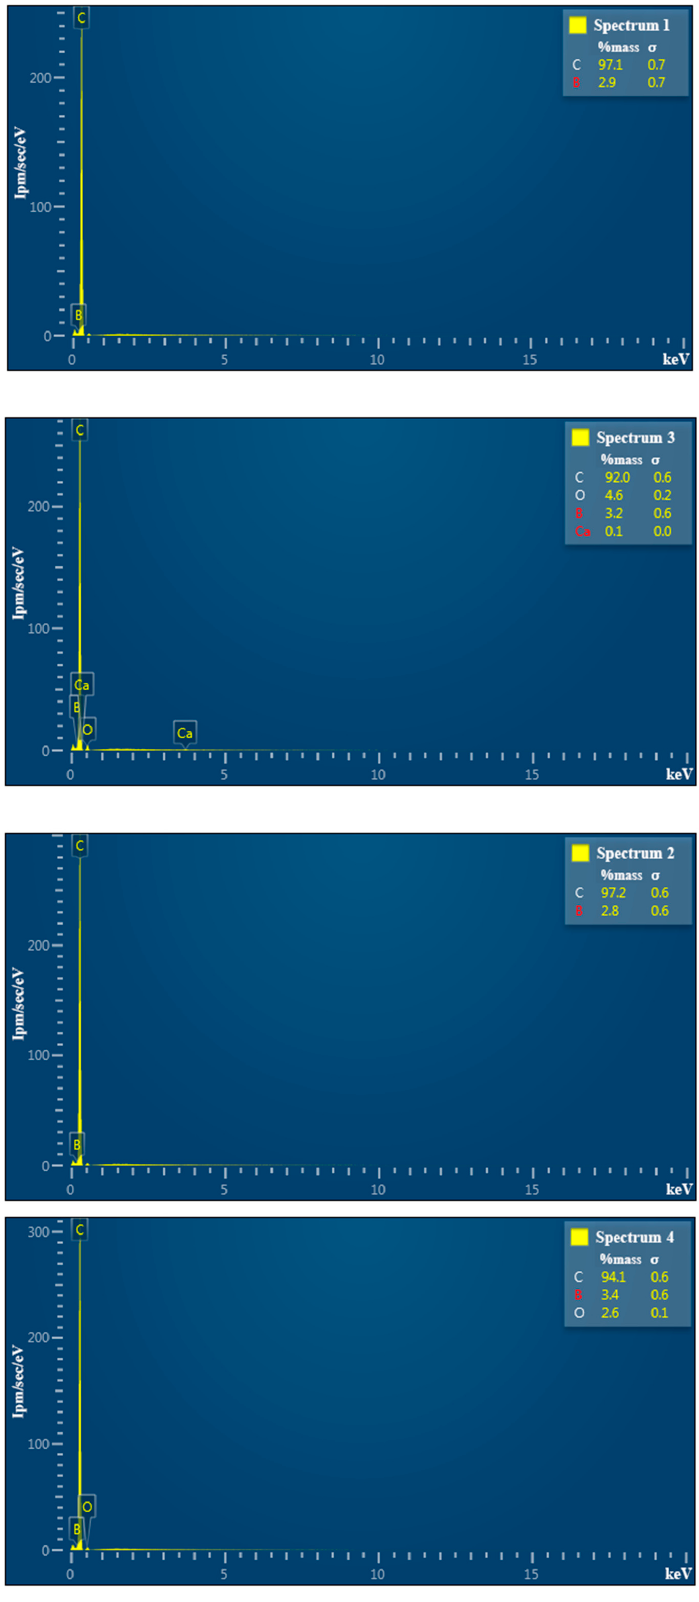
Figure 7. EDS analysis of sample 1.